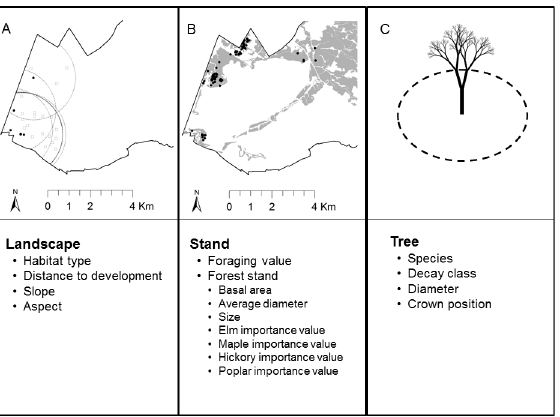
Fig 1. Diagram illustrating 3 scales of investigation (landscape, stand, and roost tree) in Indiana bat roost-site selection at Fort Drum Military Installation, New York, USA between 2007 – 2011 and habitat covariates evaluated at each scale. At the landscape and stand scales, we identified used sites that were paired with 5 available points (square points) for resource selection analysis. Panel A illustrates the location of used roost sites for Indiana bat 150 – 282 (solid points) along with a 1976-m radius buffer (dashed line) used to define availability surrounding each roost site. The Fort Drum Installation boundary is depicted by solid black line. Panel B illustrates the location of all roost sites (solid points) and forest stands for which stand attribute data were collected are in gray. Roost-site selection at the tree scale (Panel C) was evaluated based on all available trees within a 0.0405-ha plot centered on the used roost